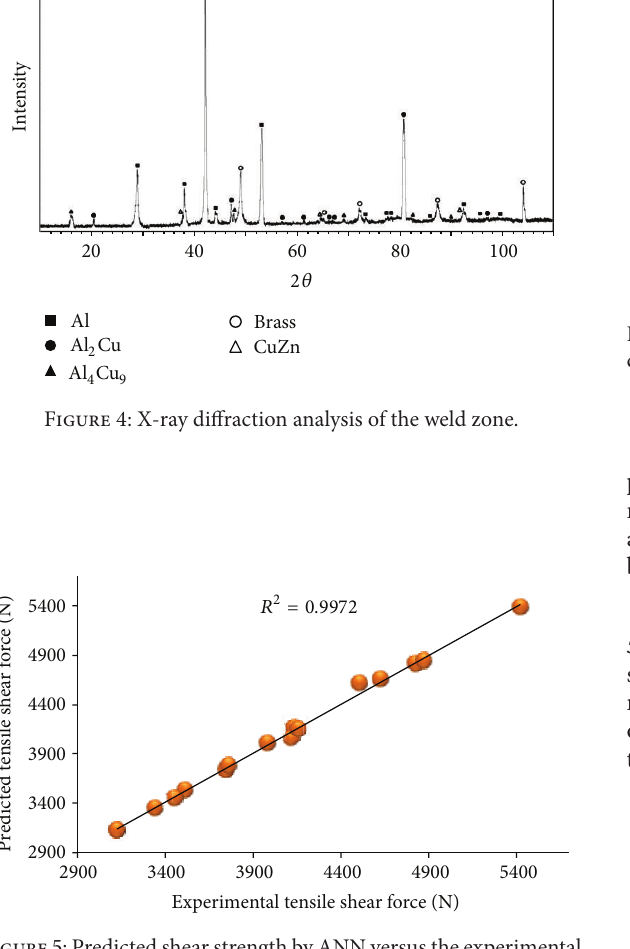
Figure 5: Predicted shear strength by ANN versus the experimental data and the regression line at the training stage for tensile shear force.